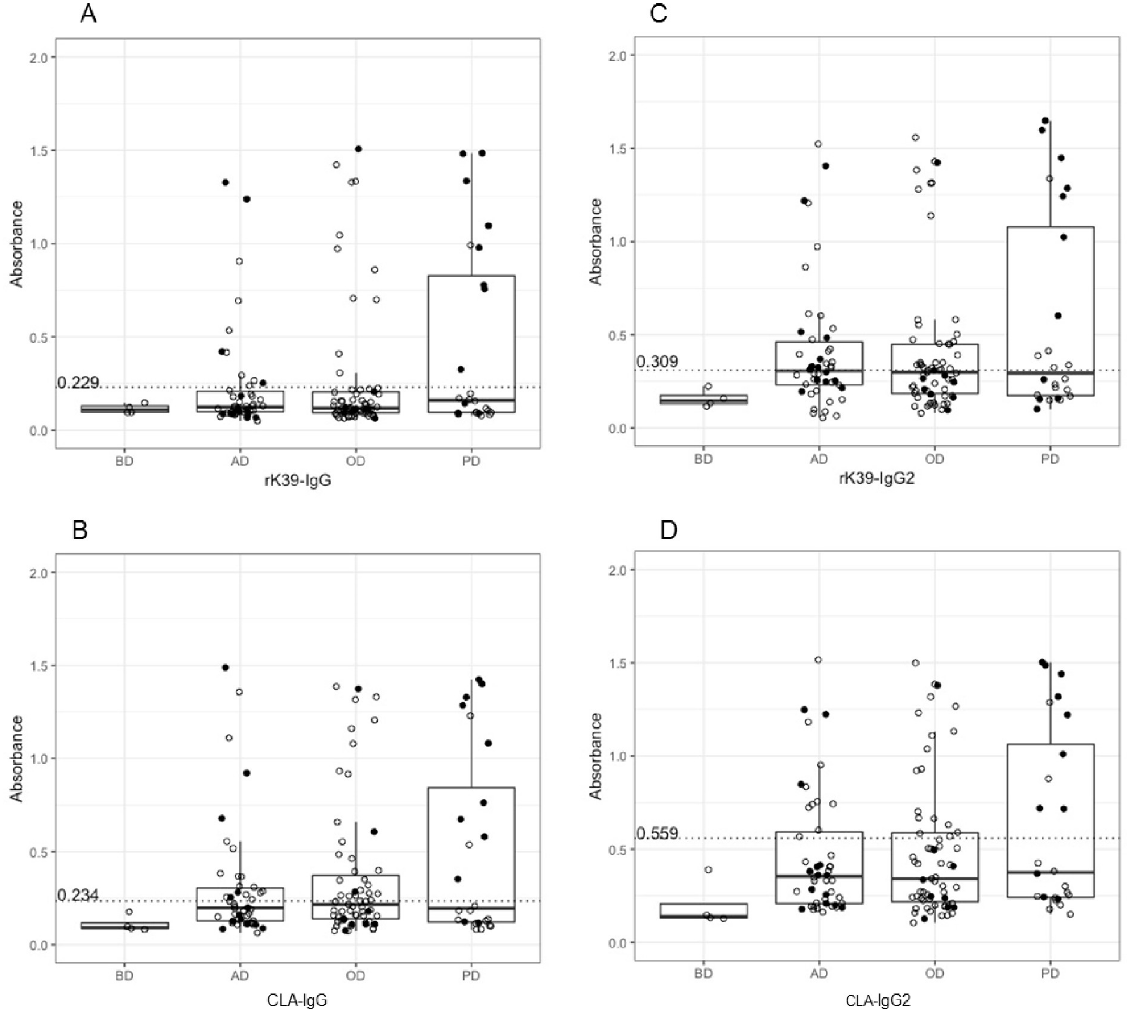
Fig 5. Anti-rK39 and anti-CLA antibody levels in serum suggest elevation of rK39 antibody titres ( p = 0.045) in polysymptomatic disease. (A) rK39-IgG, (B) CLA-IgG, (C) rK39-IgG2 and (D) CLA-IgG2 in 133 domestic dogs and four dogs from a non-endemic area. The 133 dogs were classified by clinical signs: BD, dogs from a non-endemic area; AD, asymptomatic; OD, oligosymptomatic; PD, polysymptomatic. Black dots show dogs detected as Leishmania -positive by molecular